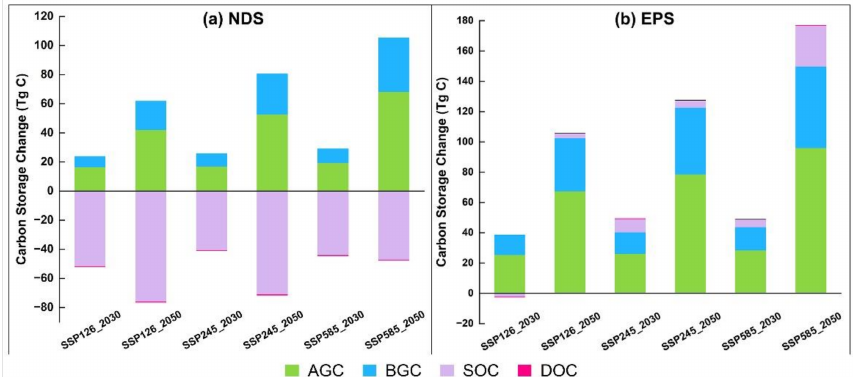
Figure 8. The change in the carbon storage of AGC, BGC, SOC, and DOC across the Gansu province in the future periods (2030 and 2050) and Future Climate Scenarios (SSP126, SSP245 and SSP585) relative to 2020. ( a ) NDS and ( b ) EPS are the different LUTC Scenarios.